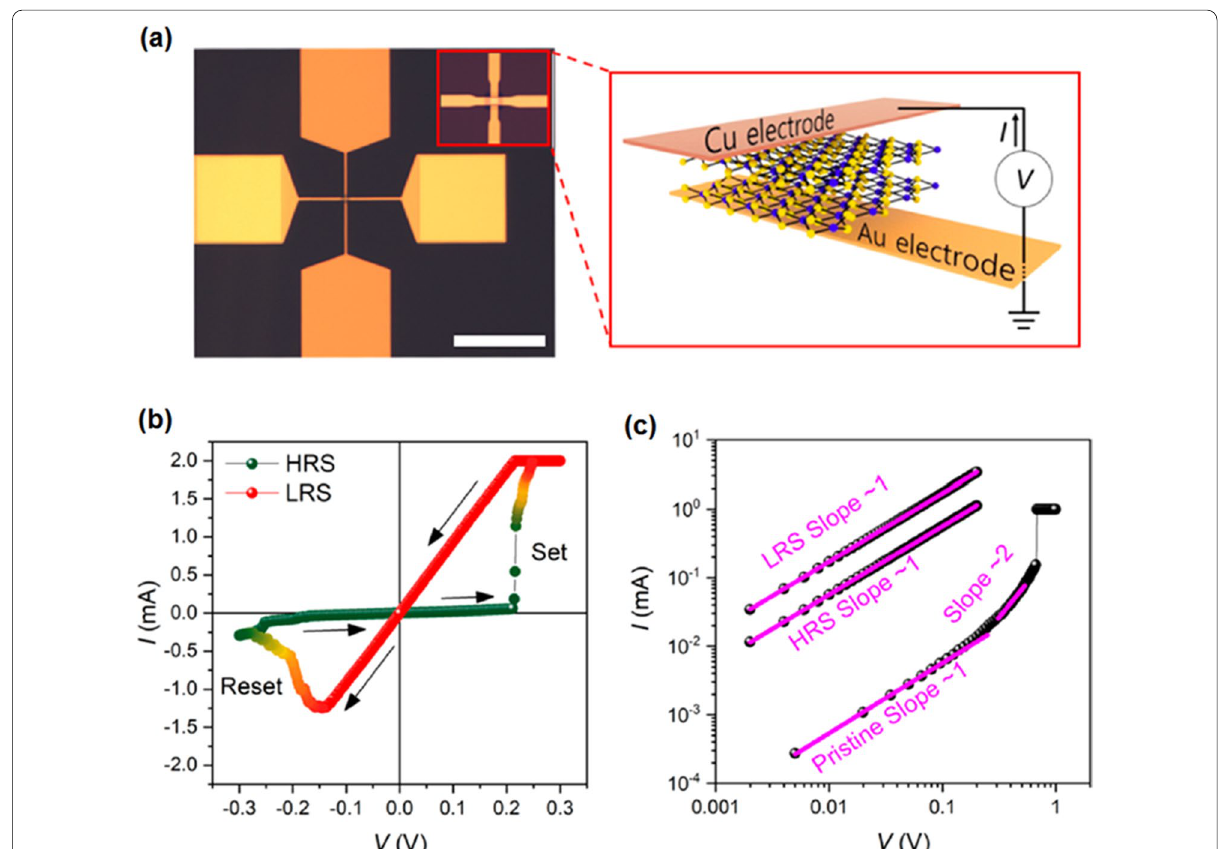
Fig. 15 The optical image of Cu/MoS 2 double layer/Au memristor device with scale bar of 100 μm accompanied by the graphical scheme of device with top Cu electrode and bottom Au electrode. The memristor’s crossbar area is 2 2 μm 2 . b The I-V curve of memristor device with bipolar RS × with the 0.25 V Set voltage and 0.15 V Reset voltage. e The logarithmic scale I – V curve of device for the pristine state before and after forming − process, and for LRS and HRS after the forming process. Reprinted with permission from